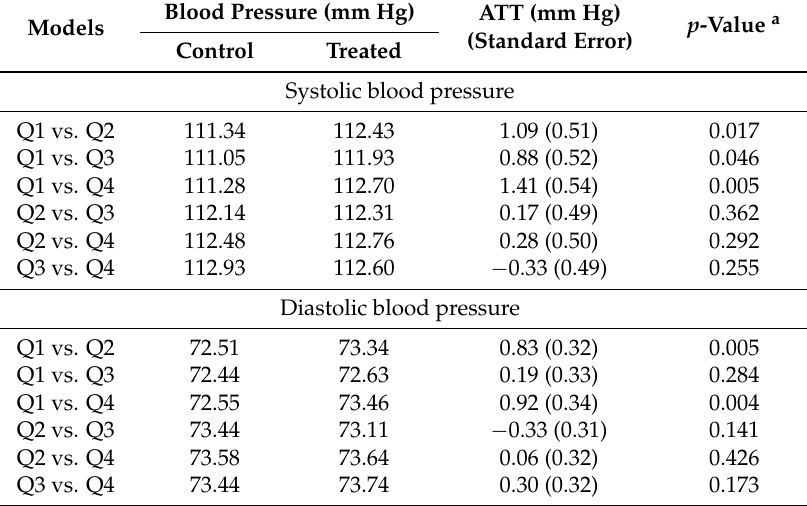
Table 5. Average treatment effects (ATT) of the sodium to potassium ratio on blood pressure for six pairwise comparisons using propensity score matching after excluding hypertension patients Blood Pressure (mm Hg) ATT (mm Hg) p -Value a Models (Standard Error) Control Treated Systolic blood pressure Q1 vs. Q2 111.34